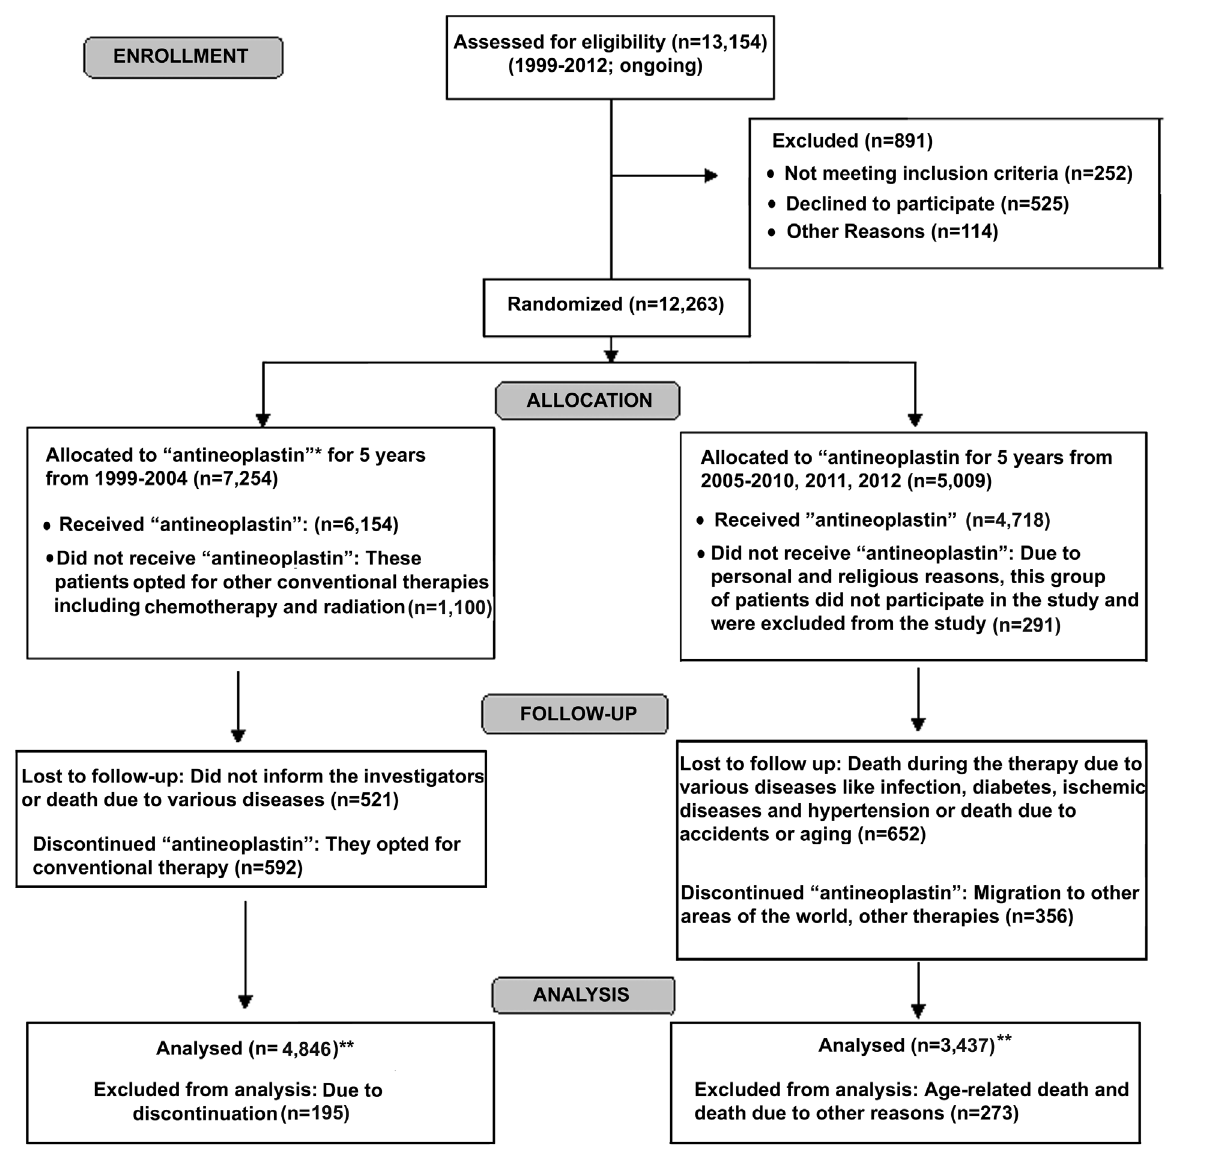
Figure 1. Flowchart representing the participation of the subjects with different cancers who received ‘‘antineoplastin’’ treatment. Patients with different cancers were selected for the study and ‘‘antineoplastin’’ pad consisting of 0.2 ml of the solution (0.28 mmol of SNP) soaked in a band-aid was applied dermally on the lower abdominal hair-free area as described before [28]. Please note that the whole process of delivering the ‘‘pad’’ containing ‘‘antineoplastin’’ takes less than 5 min. People from different parts of the world belonging to multi-ethnic and multi-cultural backgrounds have participated in the study including India, Poland, Papua New Guinea, Sri Lanka and Bangladesh. They had used this ‘‘antineoplastin’’ pad for at least a year with a maximum duration of 5